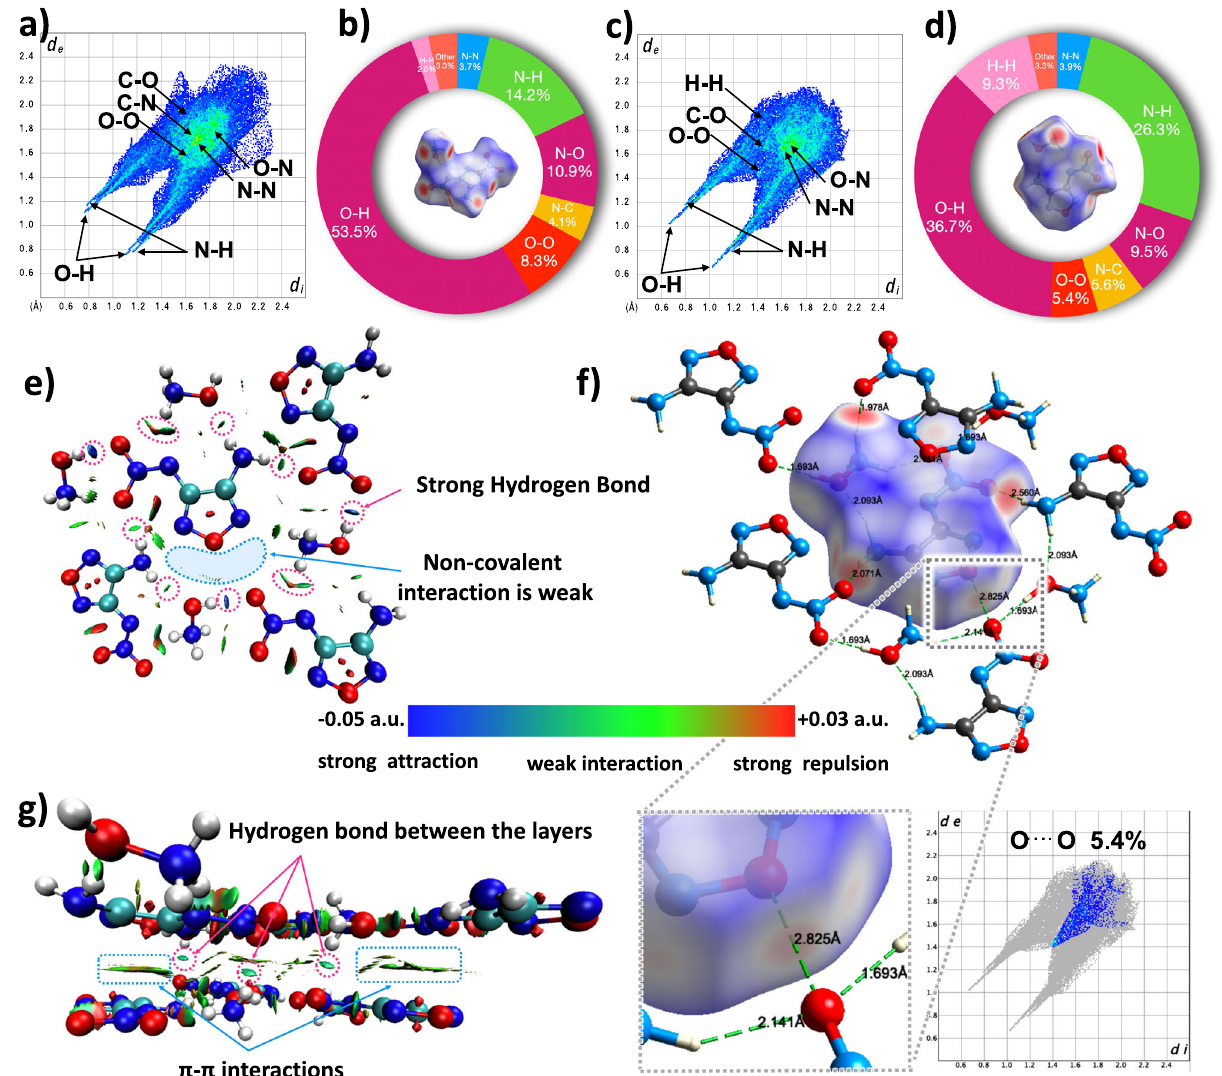
Fig.5|TheweakinteractionsinHHF-F. The2D fi ngerprintplotsincrystalstacking forHHF-T a andHHF-F c ;PiegraphsforHHF-T b andHHF-F d showthepercentage contributions of the individual atomic contacts to the Hirshfeld surface, Hirshfeld